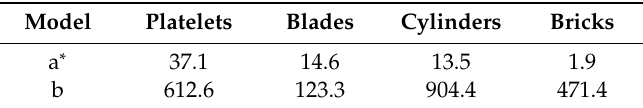
Table 1. Empirical shape factors.